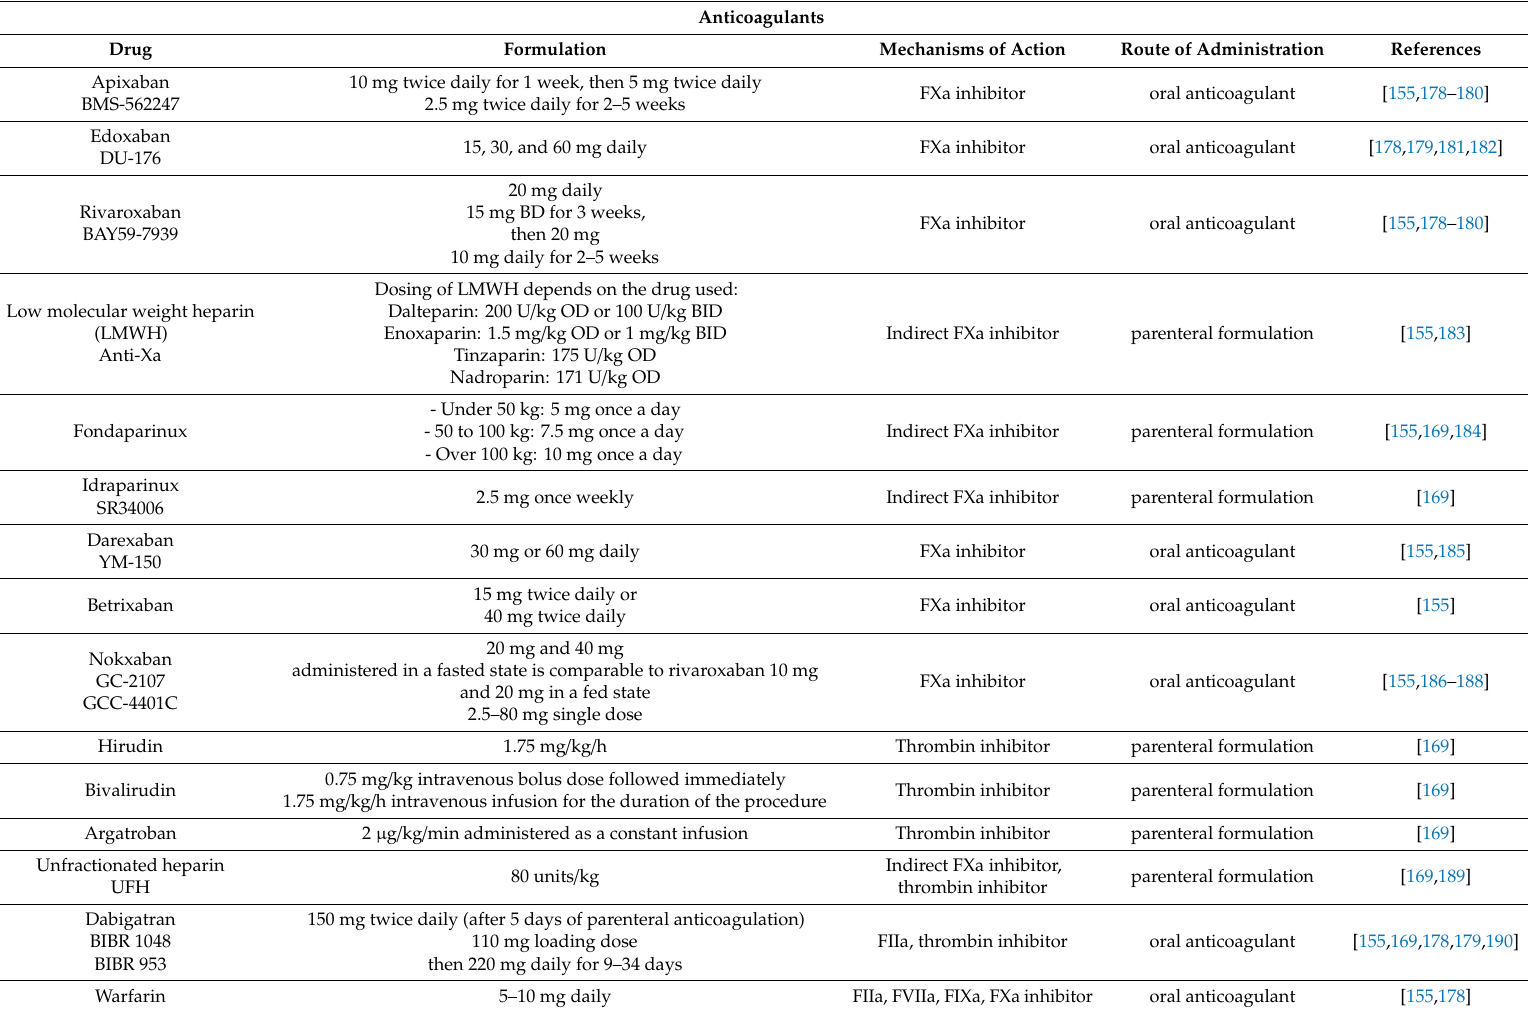
Table 1. E ff ect of drug anticoagulants for atherothrombotic